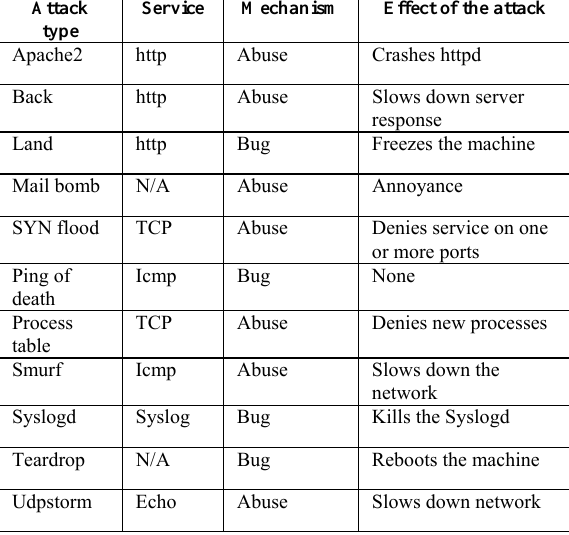
Table 1. Denial of service attack (DOS)